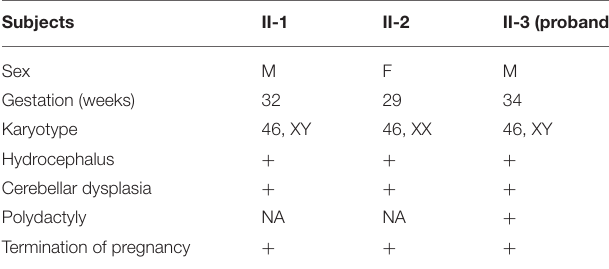
TABLE 1 | Clinical data of three fetuses in this